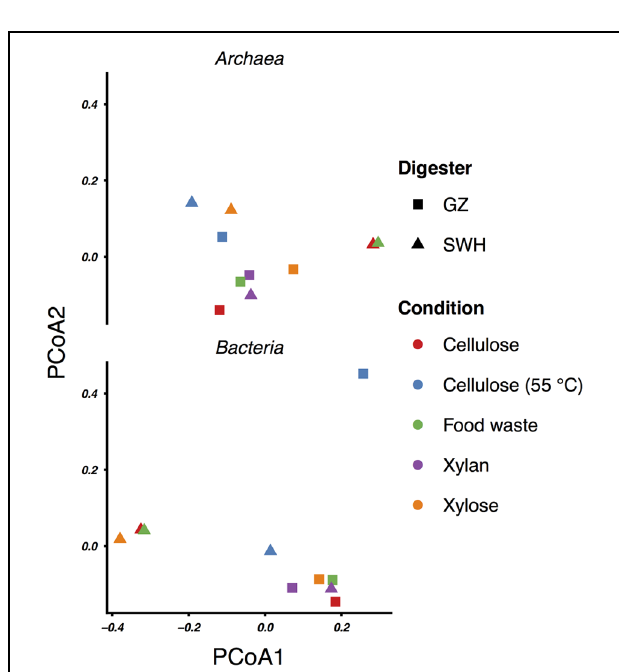
FIGURE 3 | Principal coordinates analysis (PCoA) ordinations of the weighted UniFrac distances between the archaeal and bacterial